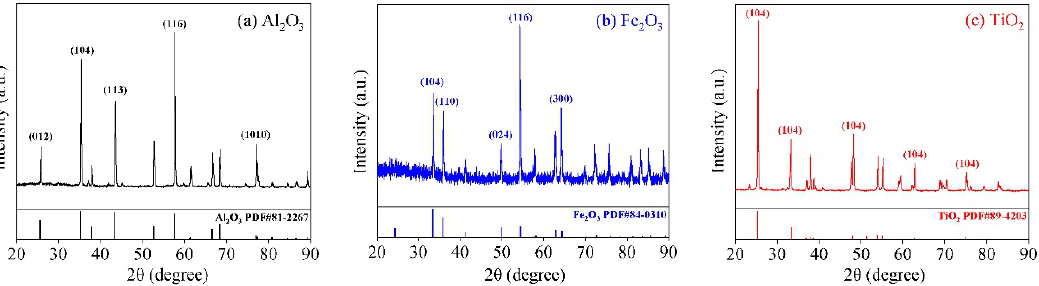
Figure 10. X-ray diffraction (XRD) patterns of the ( a ) Al 2 O 3 catalyst, ( b ) Fe 2 O 3 catalyst, and ( c ) TiO 2